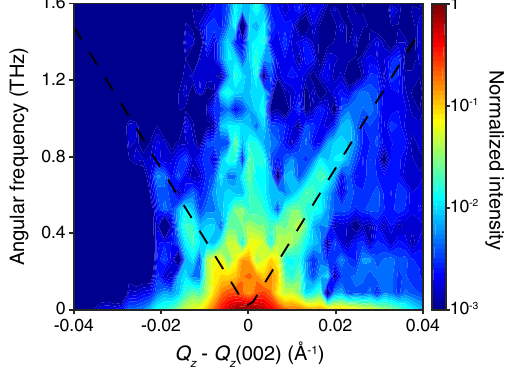
FIG. 6. Time-domain Fourier transform of the diffracted x-ray intensity near the 002 SL Bragg reflection. The intensity is normalized to the maximum intensity. The slope of the dispersion (dashed line) is v ¼ 3700 m =